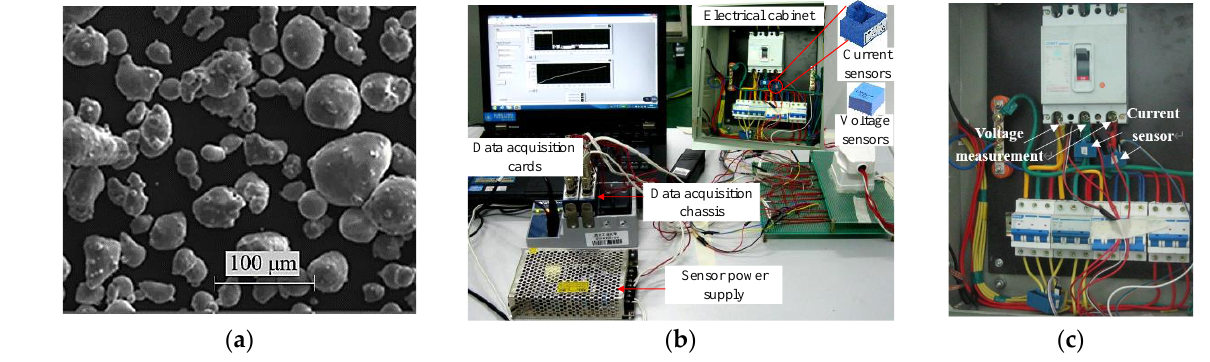
Figure 1. Experimental setup: ( a ) SEM images of the AlSi10Mg powder shape; ( b ) Energy data acquisition equipment; ( c ) Placement of the energy data acquisition equipment in the SLM machine. Table 1. Chemical compositions of AlSi10Mg alloy powder (weight percent).